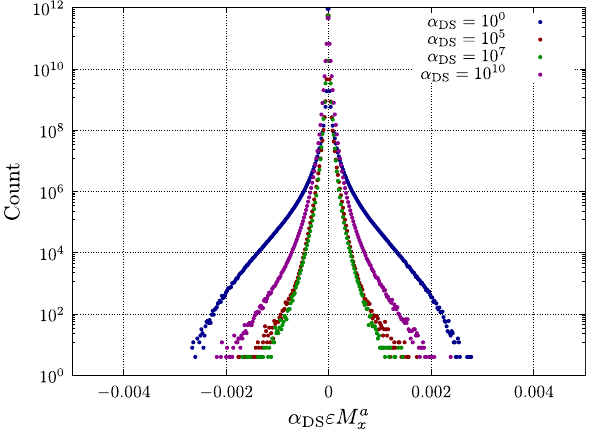
Fig. 8 Histogram of the imaginary part of the Langevin drift, i.e. Eq. (20), multiplied by the Langevin step size, for different values of the DS control parameter α DS